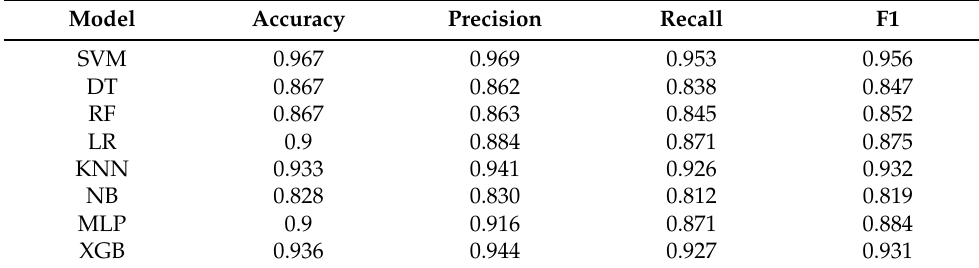
Table 6. Classifier results with dataset augmentation and feature selection.